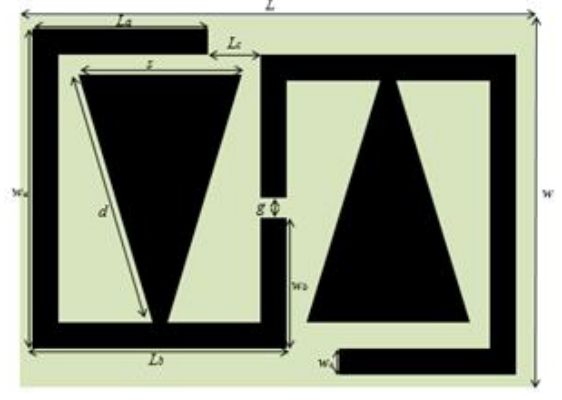
Simulated Without Triangular stubs Modeled circuit Without Matching Element Simulated With Triangular stubs Modeled circuit With Matching Element